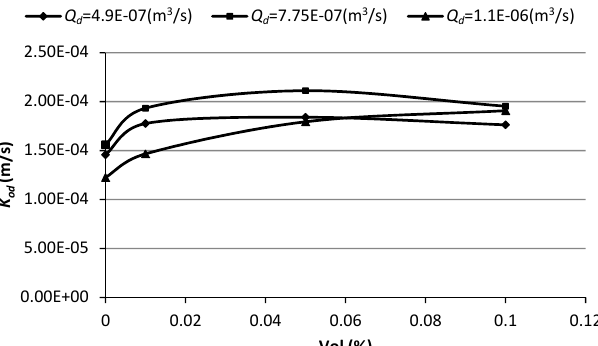
Fig. 3. Variation of mass transfer coefficient with concentration of SiO 2